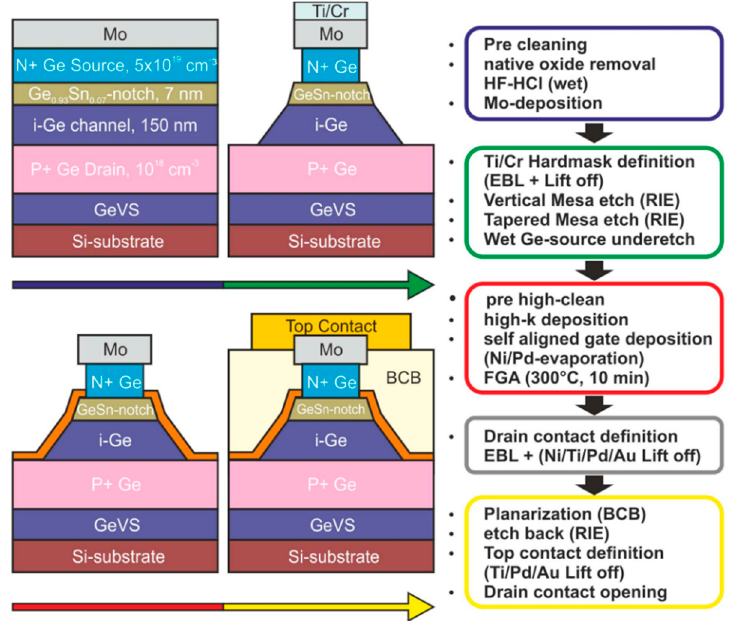
Figure 38. Process flow for Ge/GeSn vertical heterojunction pTFETs. Reproduced with permission from [99], IEEE, 2017.